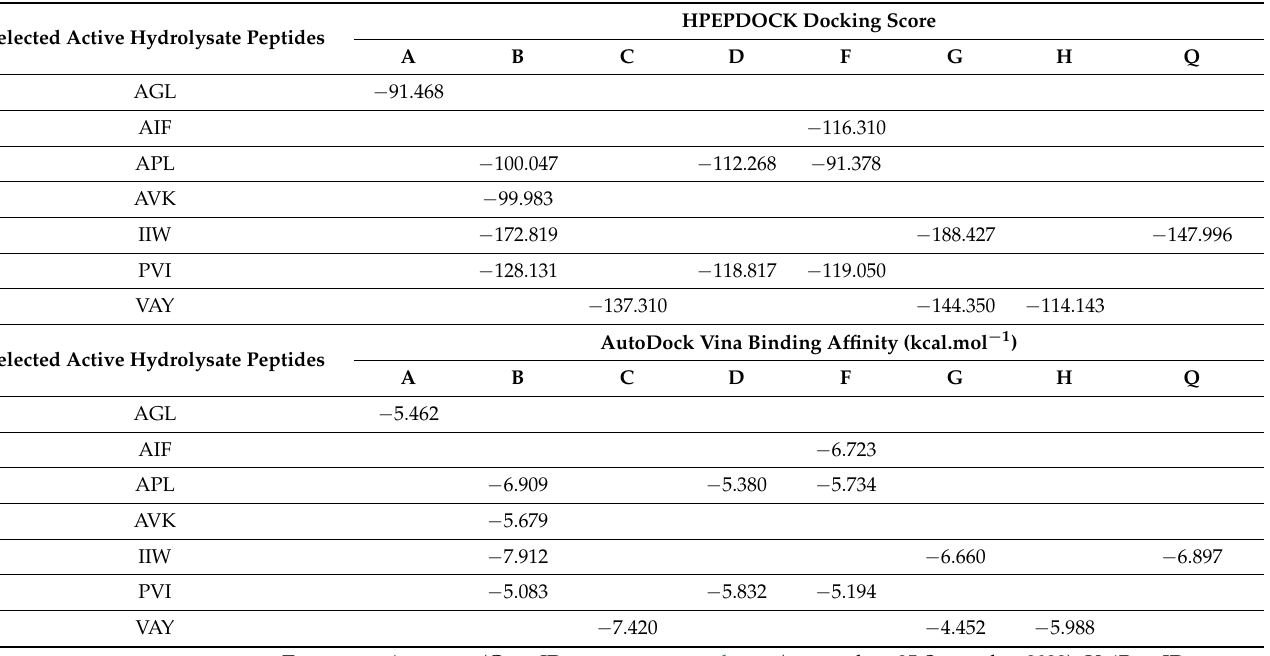
Figure 5. ALS predicted target gene network of kinases, protein-protein interactions, and transcrip- tion factors. Table 3. Docking binding affinity score of the interaction between ligands from HPEPDOCK Server and AutoDock